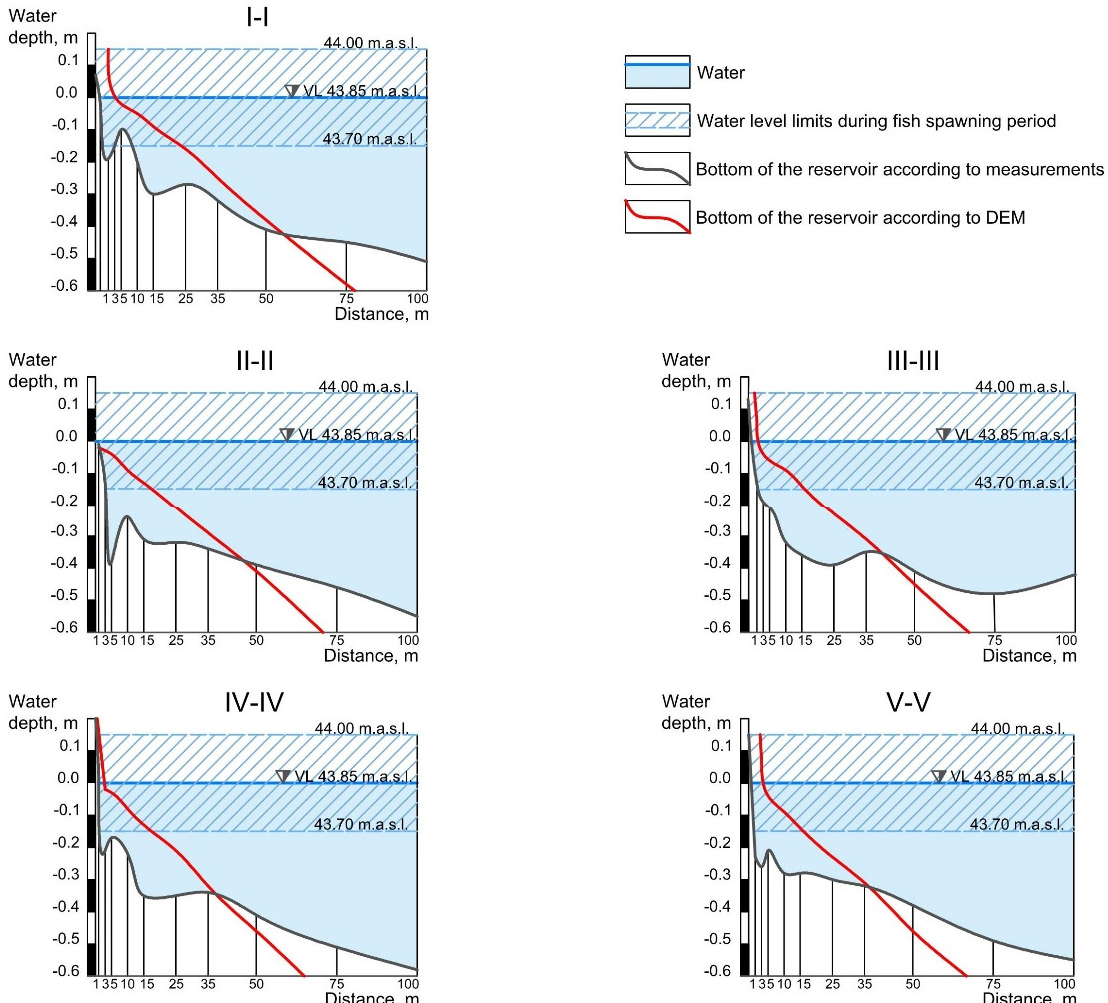
Figure 3 . Elevation profiles of the littoral zones of the reservoir. Figure 3. Elevation profiles of the littoral zones of the